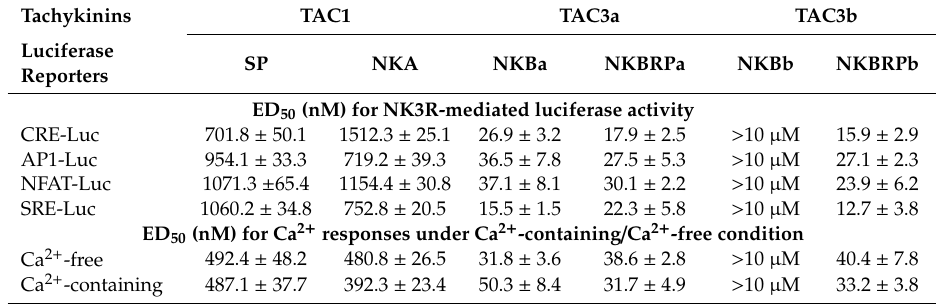
Figure 2. Functional expression and binding a ffi nity analysis of grass carp TACR3: ( A ) HEK-293 cells expressing both grass carp TACR3 and CRE-Luc were treated with various concentrations of TACR1 agonist Hemokinin-1, TACR2 agonist GR64349, and TACR3 agonist senktide (0.1–1000 nM). ( B ) HKE-293 cells with expression of grass carp TACR3 and CRE-Luc were treated with various concentrations of grass carp SP, NKA, NKBa, NKBRPa, NKBb, or NKBRPb (0.1–1000 nM). ( C ) HKE-293 cells stably expressing grass carp TACR3 were pretreated for 30 min with Hemokinin-1, GR64349, or senktide (0.1–1000 nM) prior to adding FAM-NKBRPb (10 nM). ( D ) HEK-293 cells stably expressing grass carp TACR3 were pretreated for 30 min with grass carp SP, NKA, NKBa, NKBRPa, NKBb, or NKBRPb (0.1–1000 nM) prior to adding the FAM-NKBa (10 nM). ( E ) Shown are confocal images of FAM-NKBa bound to HEK-293 cells with blank vector or grass carp TACR3-expressing vector. In this study, HEK-293 cells stably expressing TACR3 were cultured overnight on poly-D-lysine-coated cover glass slides, and then, the cells were incubated with 1 µ M FAM-NKBa for 30 min at 37 ◦ C with 5% CO 2 . The asterisk was used to reveal the significant di ff erence between two groups (“*” means P < 0.05, and “**” means P < 0.01). Table1. ED 50 valuesofthebioactivitiesofgrasscarpTAC3andTAC1geneproductsviaNK3Ractivation.